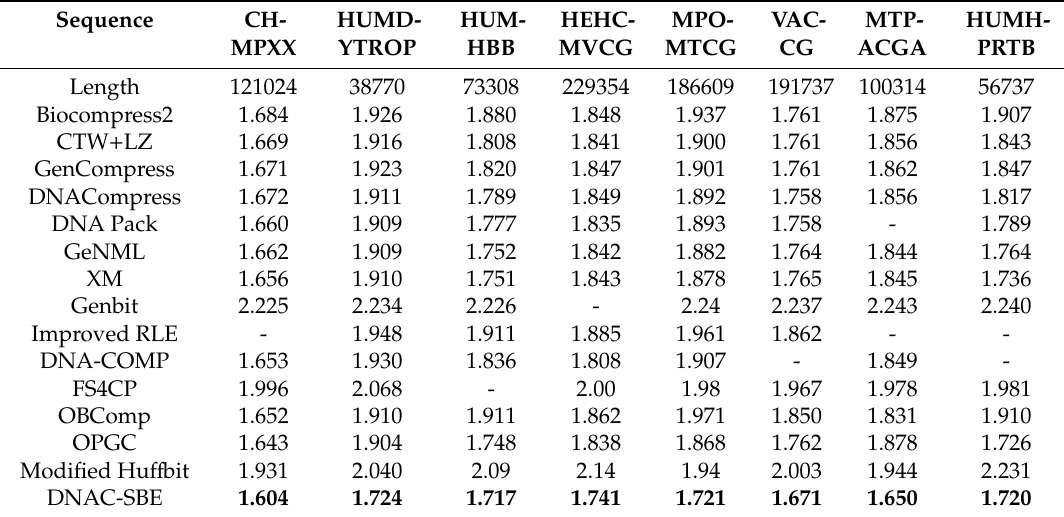
Table 4. Compression ratio of the DNAC-SEB algorithm and other DNA compression methods.